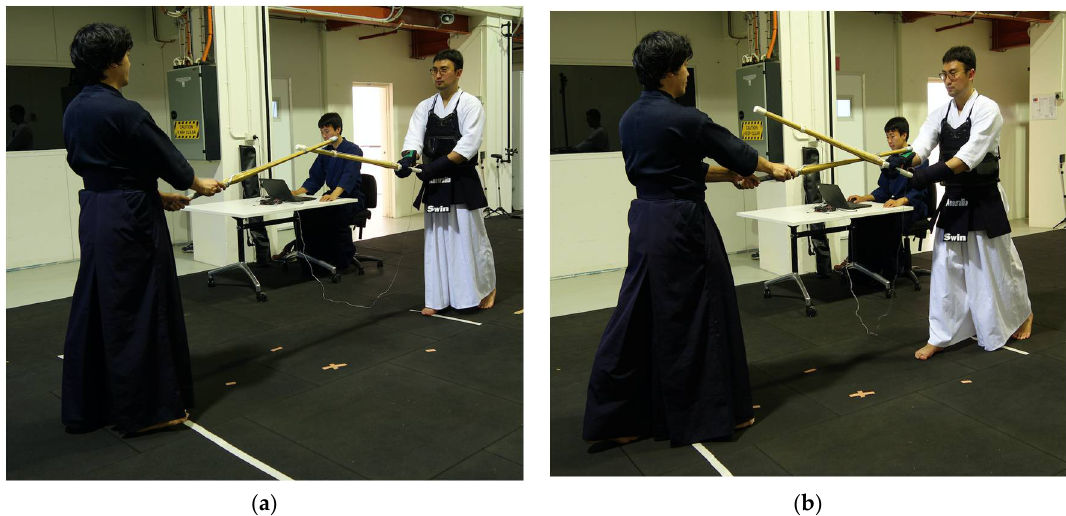
Figure 3. ( a ) Kendoka in experimental position for testing the scoring parameters; ( b ) Posture when performing Debana Kote (striking the wrist).